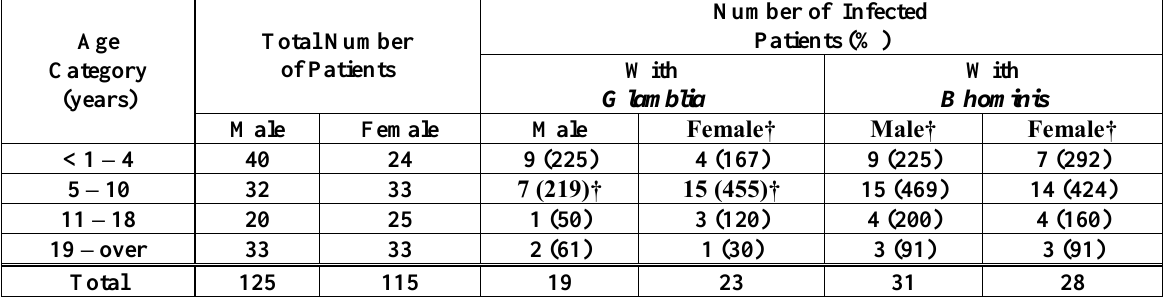
Table (6): Total number and number and percentage of male and female patients infected with G lamblia and B hominis within the four age